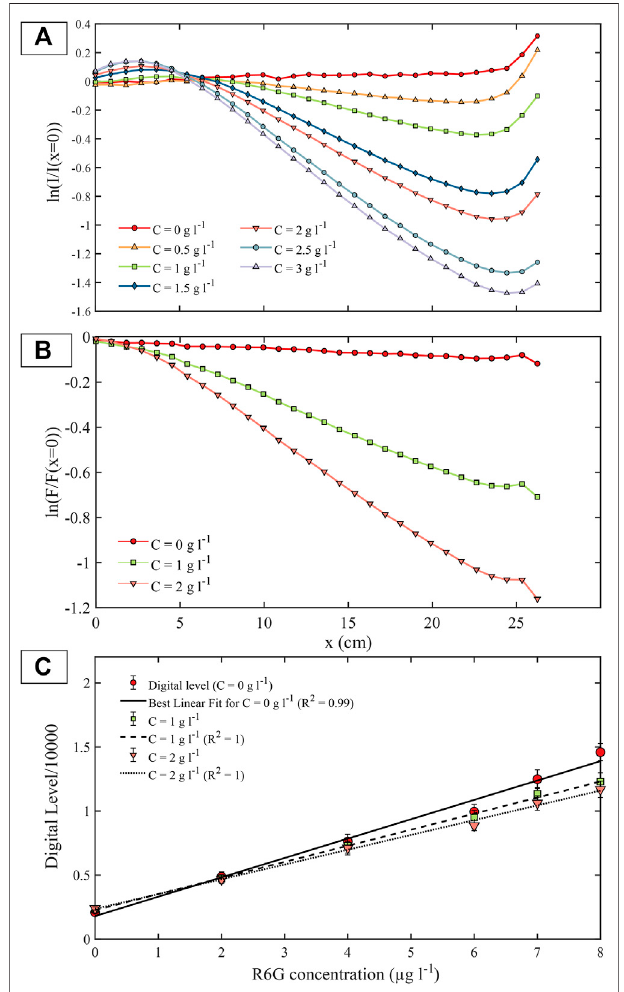
FIGURE4|(A) Pro fi leoflightintensity I asafunctionofdistancefromthe laser source x ( x (cid:2) 0 corresponds to tank wall closest to laser) for different particle concentrations (without R6G). (B) Decrease of fl uorescence intensity F for selected particle concentrations in PLIF calibrations. Note that, in both (A,B) ,intensityisexpressedasalogarithmnormalizedwithitsvalueat x (cid:2) 0. (C) ExampleofLinearrelationsbetweenR6Gconcentrationandpixeldigital level at different particle concentrations for a given pixel. The fl uorescence intensity received by the camera diminishes with particle concentration, modifying the slope p . Vertical error bars in panels A and C represent the standard deviation of the averaged pixel digital level over 10 s.